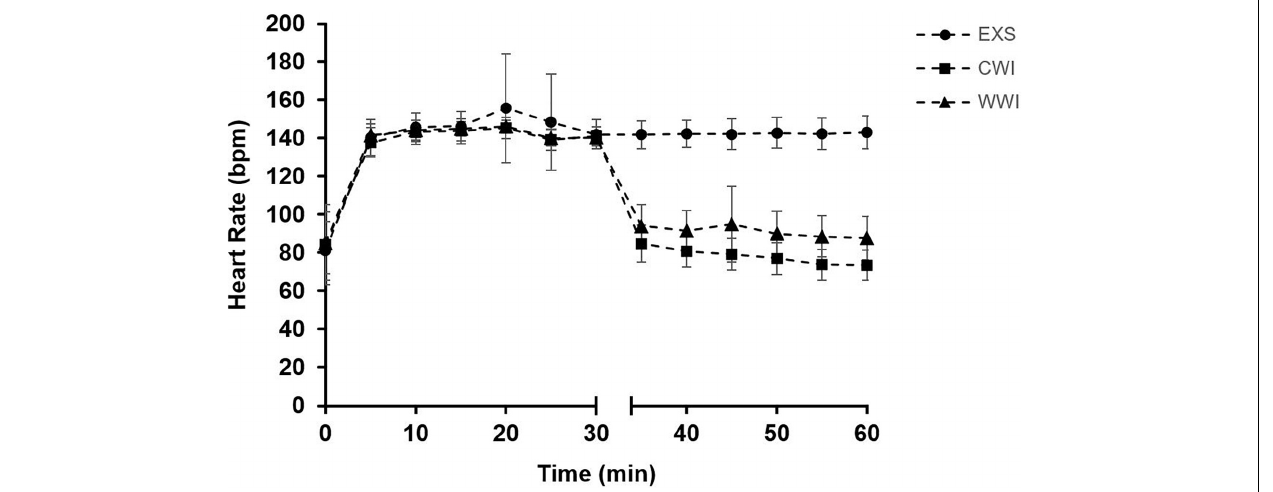
FIGURE 3 | Mean heart rate [ HR (bpm)] during time-matched exercise [EXS ( n = 16)], post-exercise Cold Water Immersion [CWI ( n = 14)] and post-exercise Warm Water Immersion [WWI ( n = 14)]. After 30 min of cycling, CWI and WWI began 30 min of water immersion (indicated by gap in x -axis). HR was not significantly different between interventions from 0 to 30 min but was significantly higher with EXS than WI ( p < 0.001) from 0 to 60 min. HR was significantly higher during the 30 min of WWI when compared to CWI ( p = 0.002).